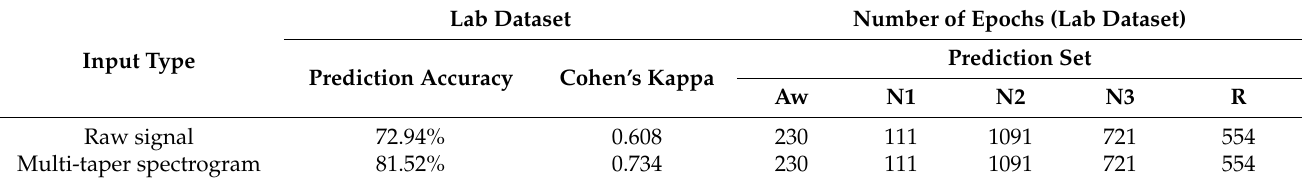
Table 3. Lab dataset prediction based on classification models trained and tested with raw signal and multi-taper spectrograms, and the combined number of epochs of each sleep